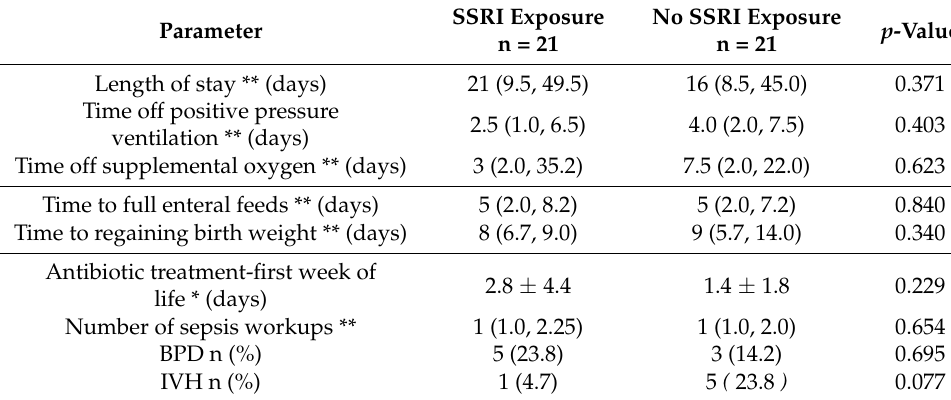
Table 3. Short-term outcomes and complications of